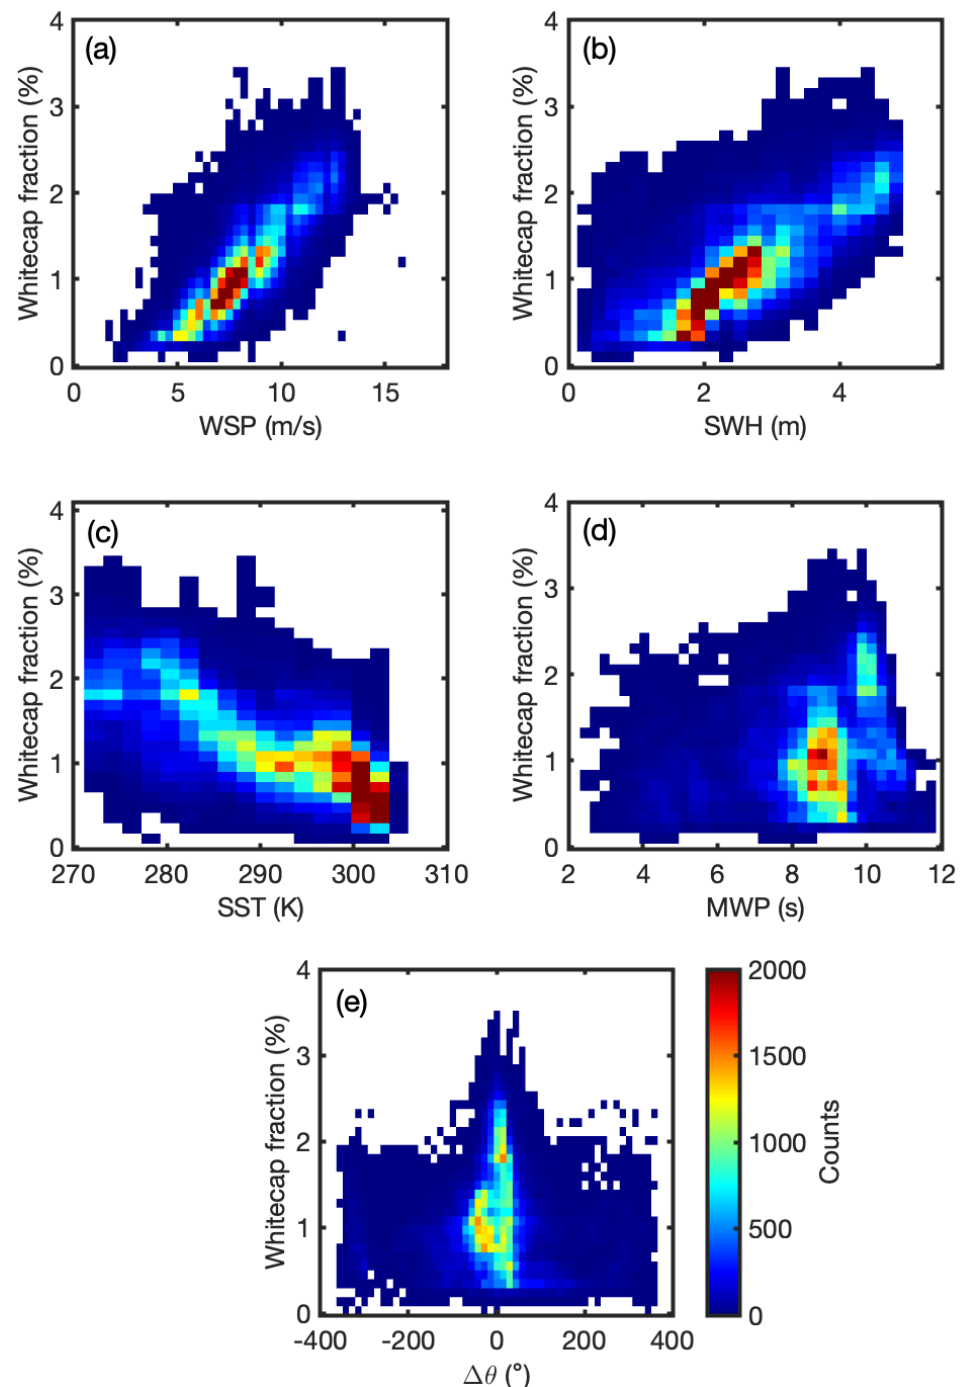
Figure 1. Binscatter plots of whitecap fraction ( W ) with different variables; ( a ) the wind speed from QuikSCAT (WSP); ( b ) significant wave height (SWH); ( c ) sea surface temperature (SST); ( d ) mean wave period (MWP); ( e ) deviation of wind direction from wave direction ( ∆𝜃 ).